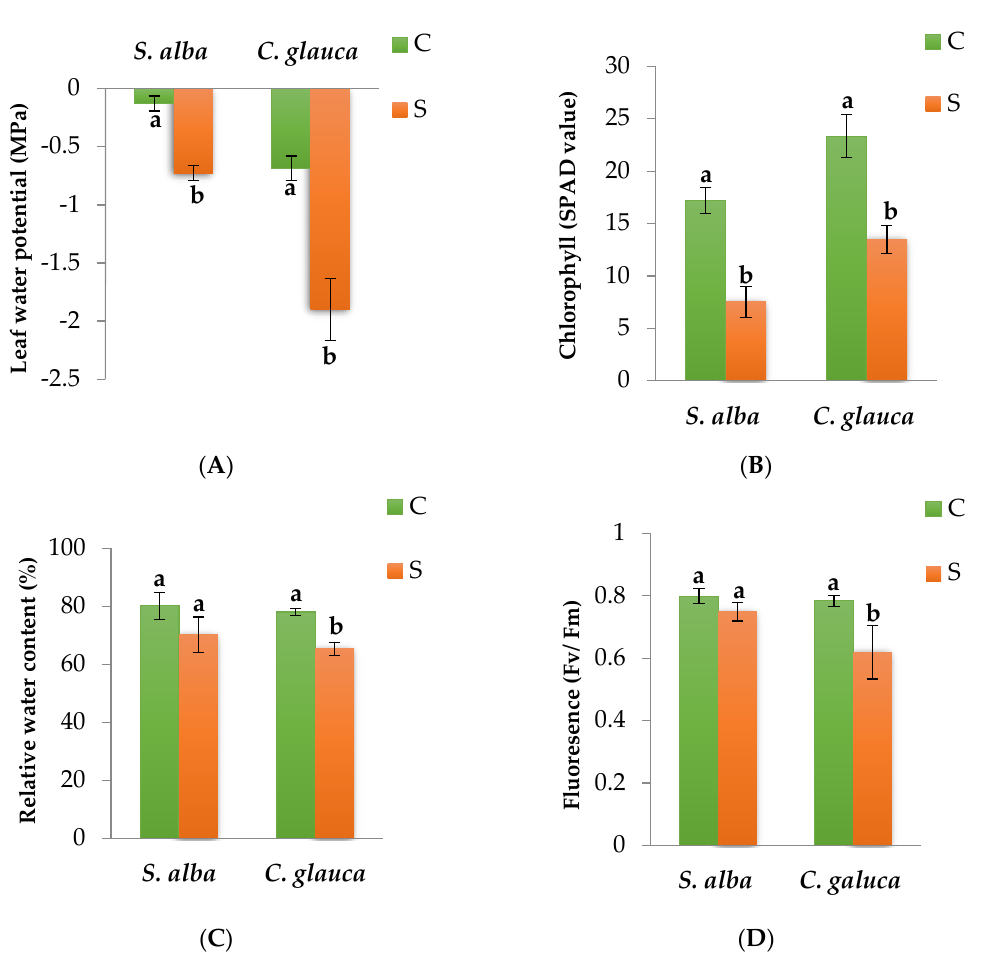
Figure 4. Variation in leaf water potential ( A ), SPAD value ( B ), relative water content ( C ) and chlorophyll fluorescence ( D ) measured after 12 days in S. alba and C. glauca treated with 25% industrial wastewater (25% IWW; stress, S) or with tap water (control, C), (n = 5, mean ± SD). Different letters above the means indicate a significant difference at p < 0.05 according to SNK tests.